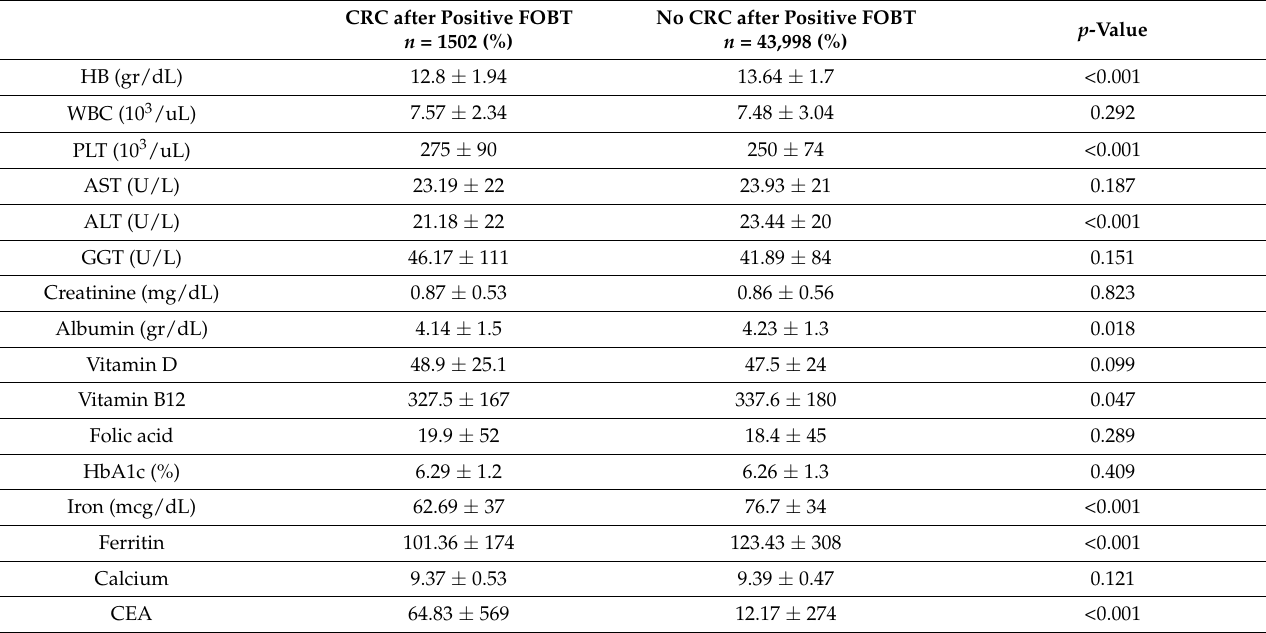
Table 2. Laboratory values of the study groups.